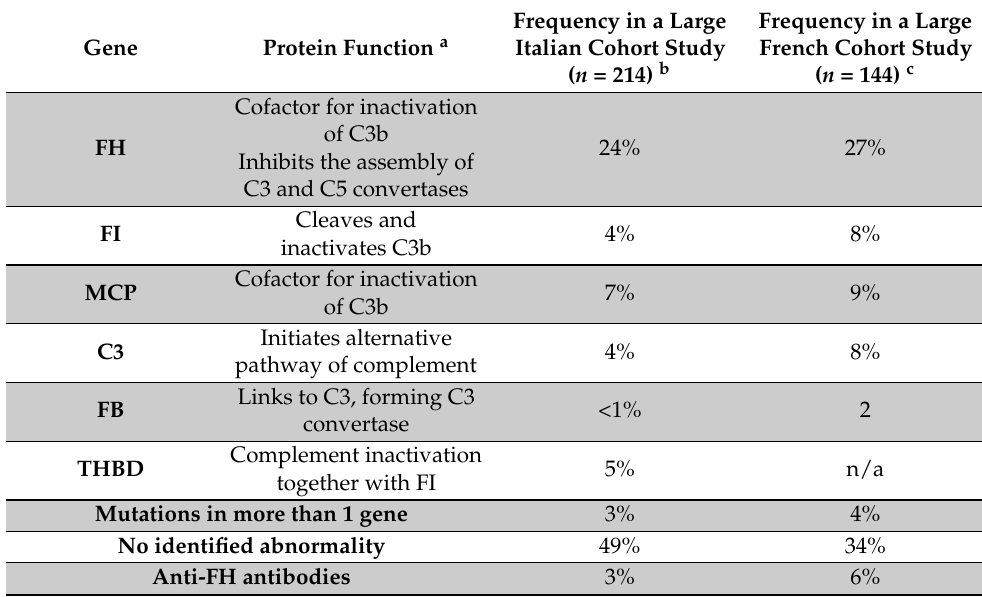
Table 6. Complement-related genes, their function and frequency of pathogenic mutations according to two large cohort